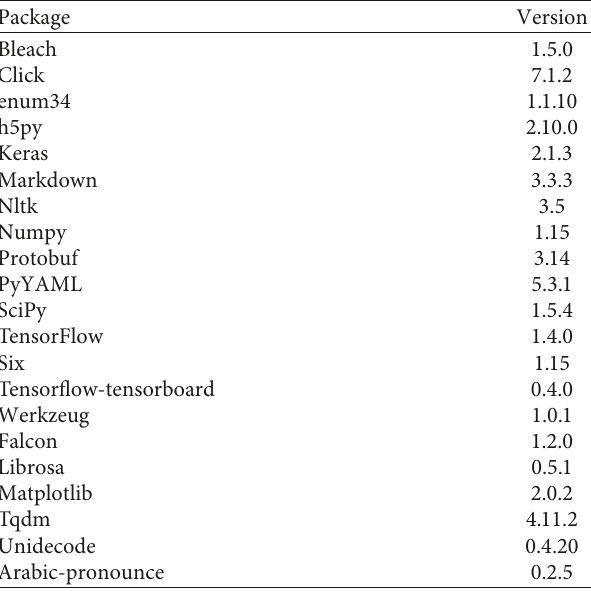
Table 1: Libraries